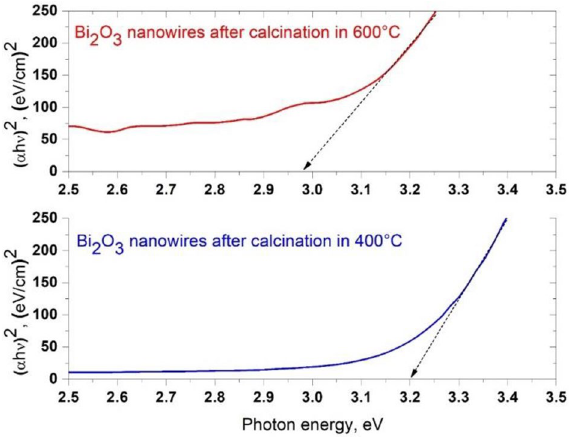
Figure 10. Formulas (αhν) 2 as a function of the quantum radiation energy obtained for one-dimensional bismuth oxide nanostructures produced by calcination of fibrous composite PAN/Bi 2 O 3 mats at 400 °C and 600